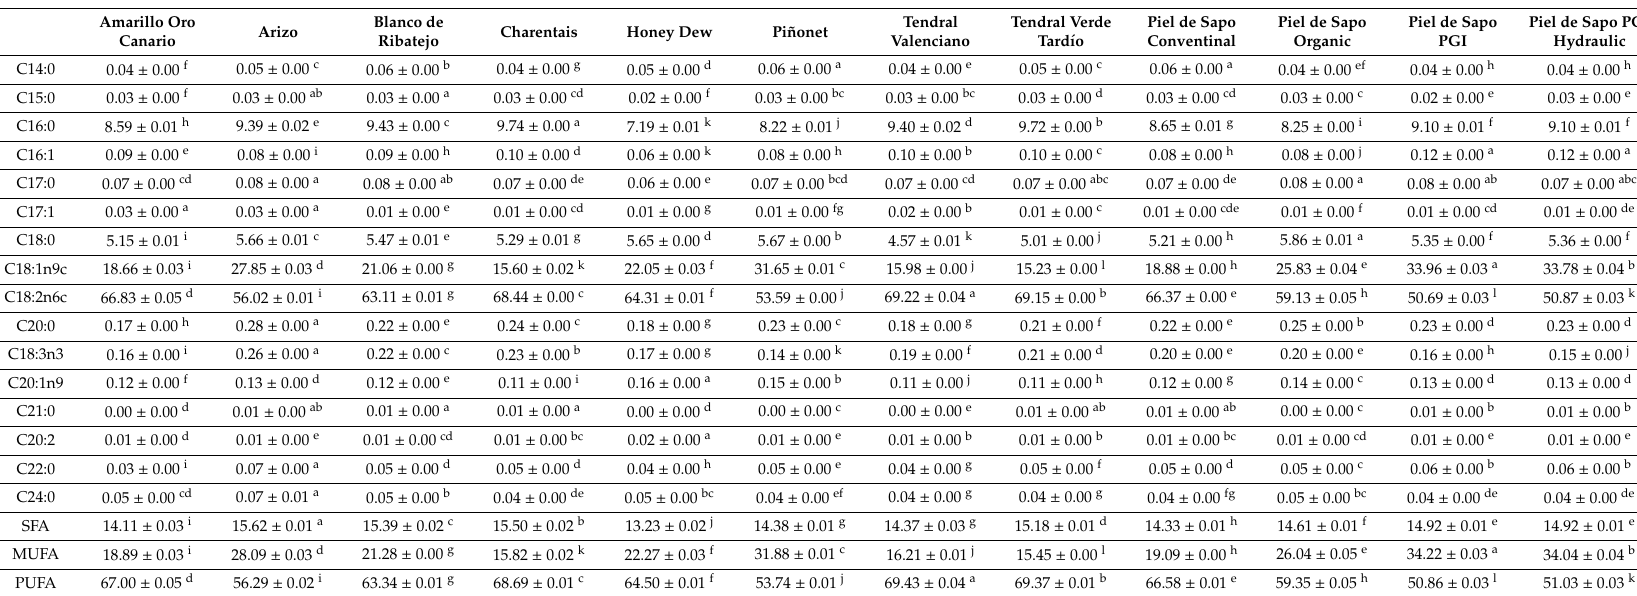
Table 3. Fatty acid profile (g / 100 g of oil) of obtained melon-seed oils. All oil samples were extracted with screw press except the last column, which shows results of fatty acid profile of oil from cv Piel de Sapo (PGI), extracted with hydraulic